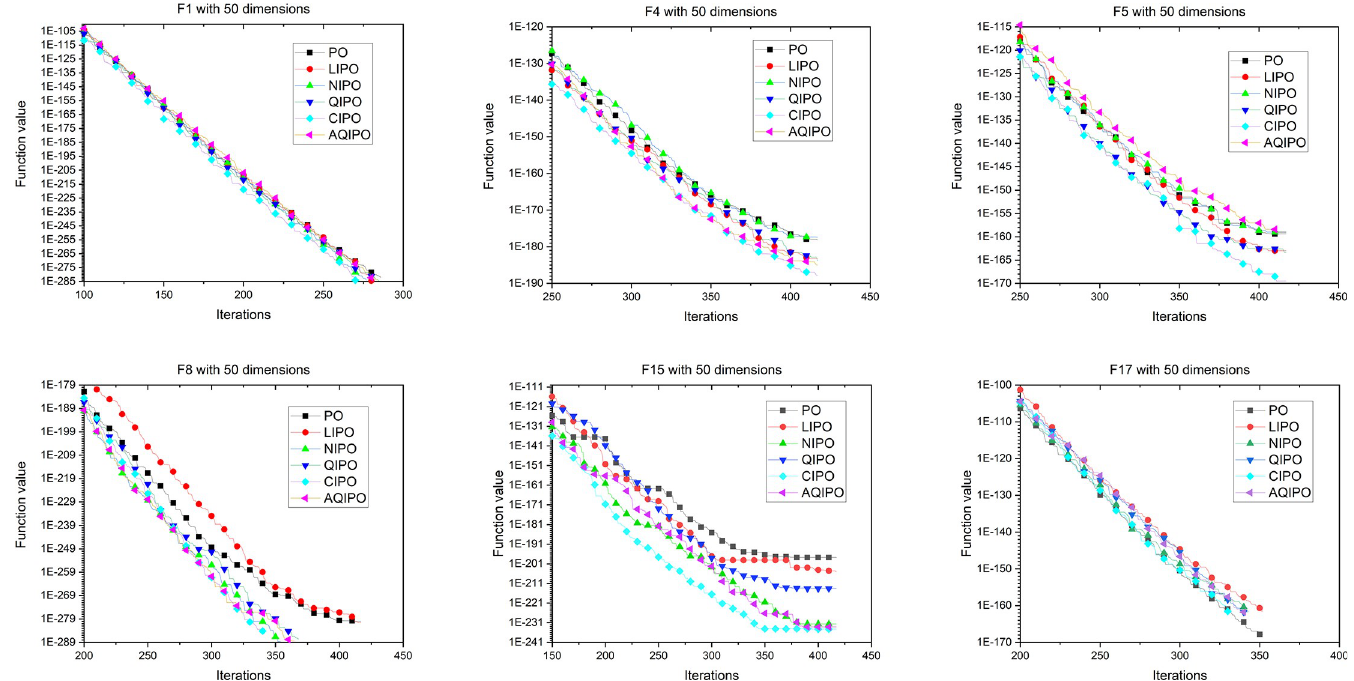
Fig 10. Convergence curve on 6 representative benchmark functions with 50